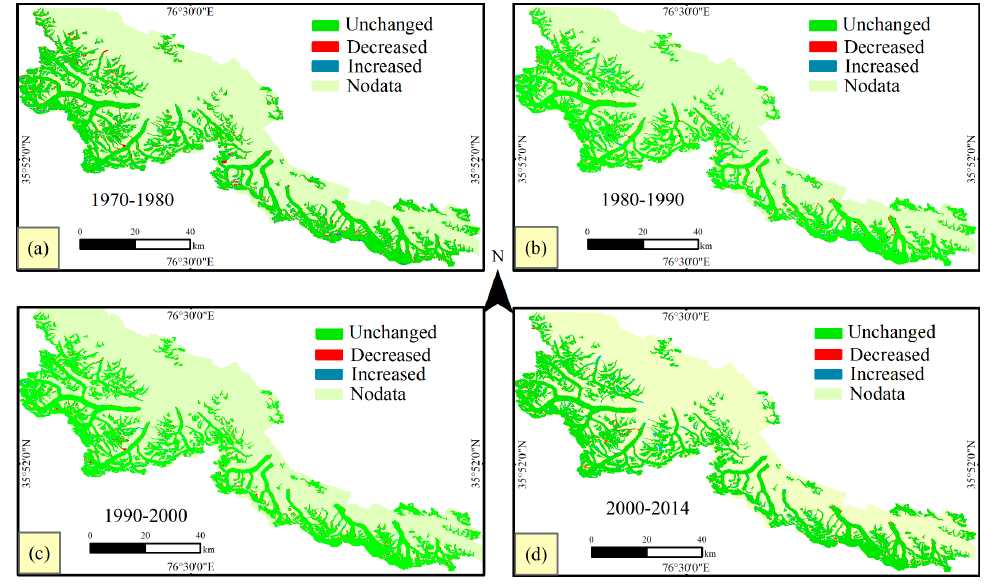
Figure 11. Spatial patterns of glacier area change during 1970–1980 ( a ), 1980–1990 ( b ), 1990–2000 ( c ) and 2000–2014 ( d )